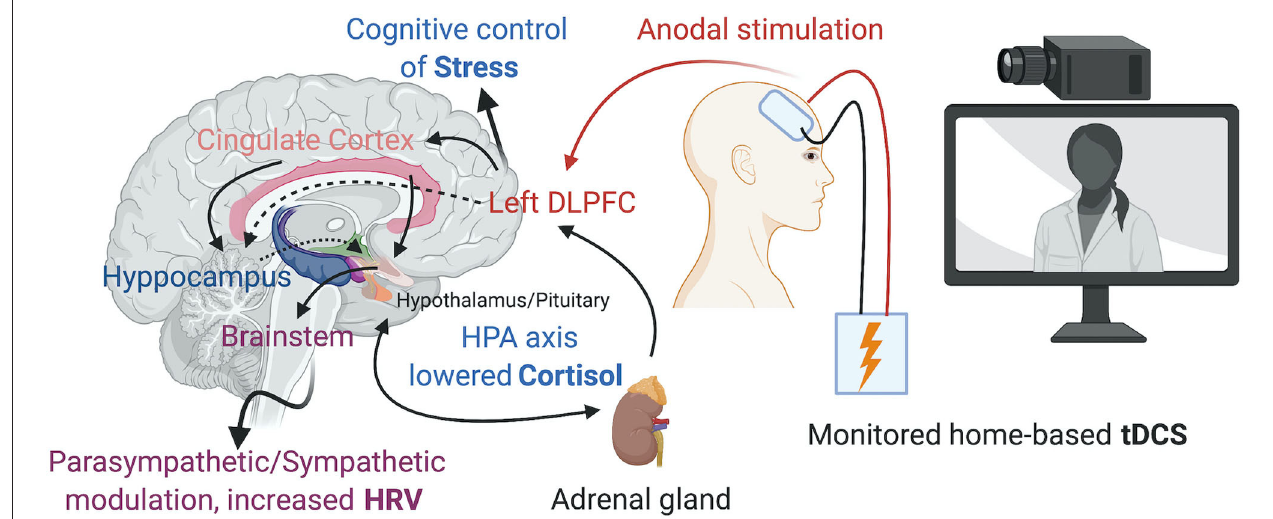
FIGURE 1 | Home-based tDCS over the left DLPFC promoting the cognitive control of Stress, changes in the HPA axis and Parasympathetic/Sympathetic modulation. Created with